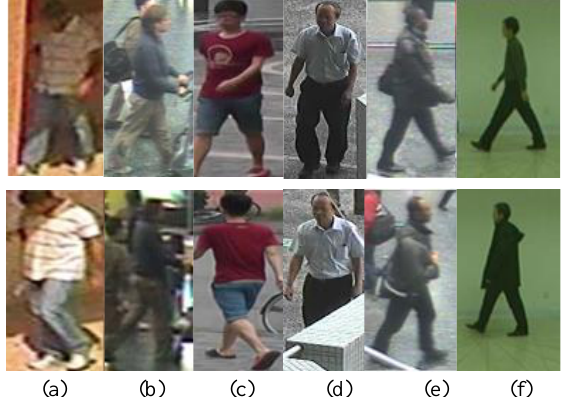
Figure 1. Person Re-ID challenges: ( a ) low resolution (3DPes dataset [14]), ( b ) illumination (iLIDS-VID dataset [15]), ( c ) viewpoint variant (Market1501 dataset [16]), ( d ) occlusions(CUHK03 dataset [17]), ( e ) similar apperance (iLIDS-VID dataset [15]), ( f ) appearance changed (CASIA Gait Database B